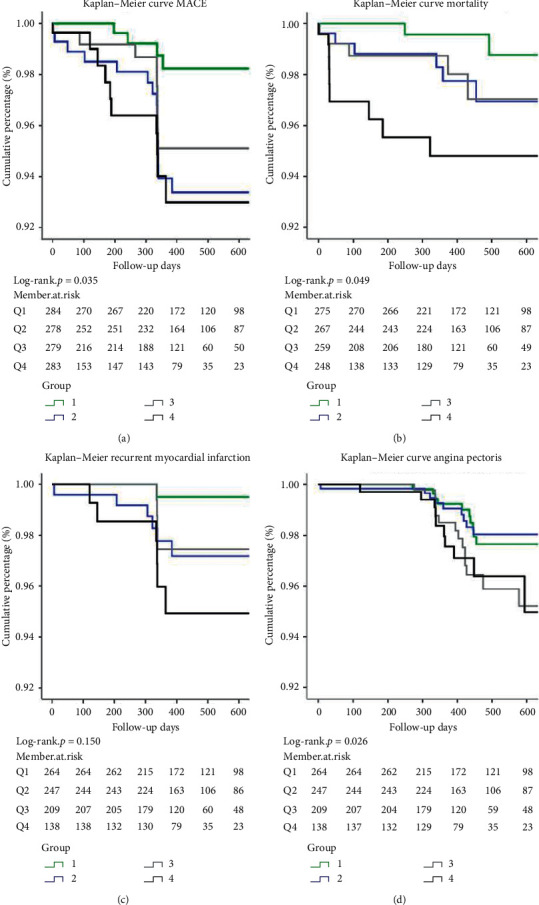
Cumulative incidence of myocardial infarction or cardiac death in patients with troponin concentrations. Patients were stratified into four groups based on the △cTnI level. Q1: first quartile (green line); Q2: second quartile (blue line); Q3: third quartile (grey line); and Q4: fourth quartile (black line). (a) Kaplan–Meier curves depicting the cumulative probability for MACE (log rank p = 0.035). (b) Kaplan–Meier curves depicting the cumulative probability for mortality (log rank p = 0.049). (c) Kaplan–Meier curves depicting the cumulative probability for recurrent myocardial infarction (log rank p = 0.150). (d) Kaplan–Meier curves depicting the cumulative probability for angina pectoris (log rank p = 0.026). MACE: major adverse cardiovascular events.